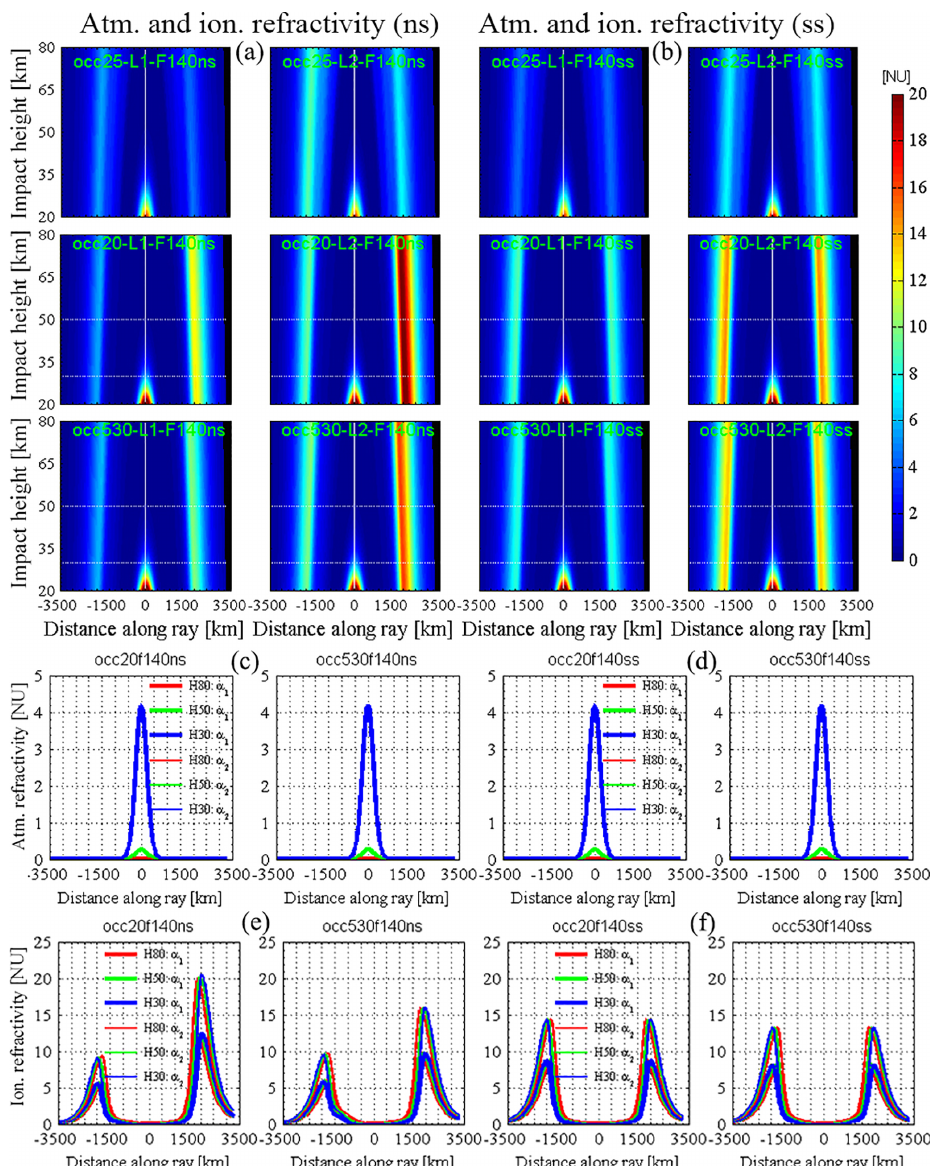
Figure 4. Images of the atmospheric and ionospheric refractivity (Eq. 4) in the along-ray distance (relative to tangent point) vs. impact height coordinate system for non-spherical-symmetry (a) and spherical symmetry (b) ionospheric conditions, for medium solar activity (F10.7 = 140) and for the GPS frequencies L1 (left sub-panels), and L2 (right sub-panels) for the three representative events (Occ.25, top sub-panels; Occ.20, middle sub-panels, Occ.530, bottom sub-panels). The narrow black stripe visible in the images near the right margin (3500km along-ray distance) is space above the LEO height (reached at around 3250km). The two bottom rows depict the corresponding along-ray behavior of the atmospheric (c, d) and ionospheric (e, f) refractivities at three representative impact heights (red, 80km; green, 50km; blue, 30km) for non-spherical (left; c and e ) and spherical (right; d and f ) ionospheric conditions, for the Occ.20 (left sub-panel in c – f ) and Occ.530 (right sub-panel in c – f ) event. The sub-panel titles (green in a – b panels, black on top of c – f panels) identify the individual cases by a concise acronym; the physical units used are refractivity (N) units (1NU = 10 6 × (n − 1)).